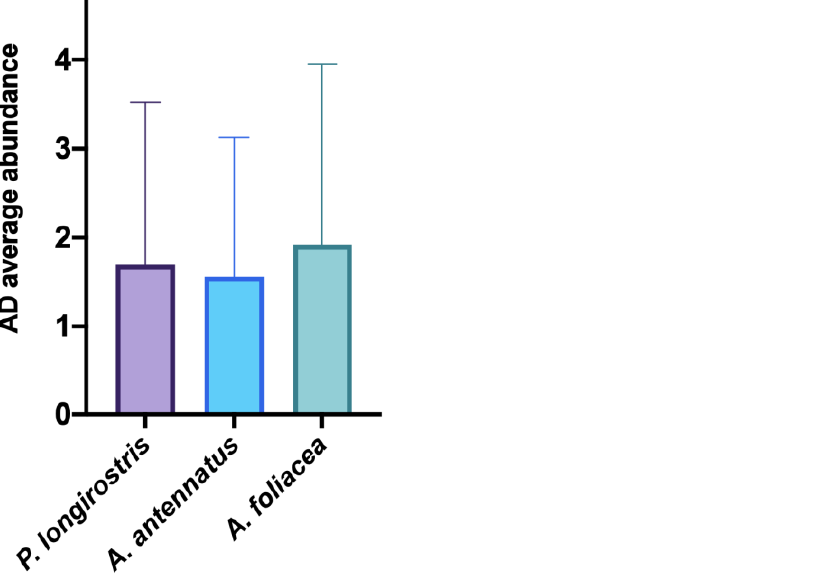
Figure 5. Microparticles abundance comparison between the three species analyzed.